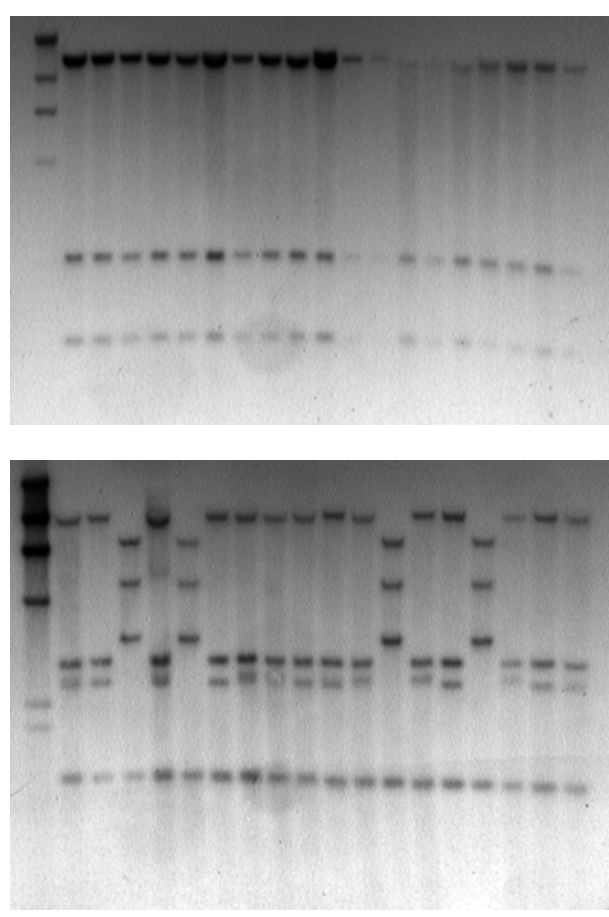
Figure 4 - Southern blots of Hpa I and Apa I restriction fragments from Brycon opalinus mitochondrial